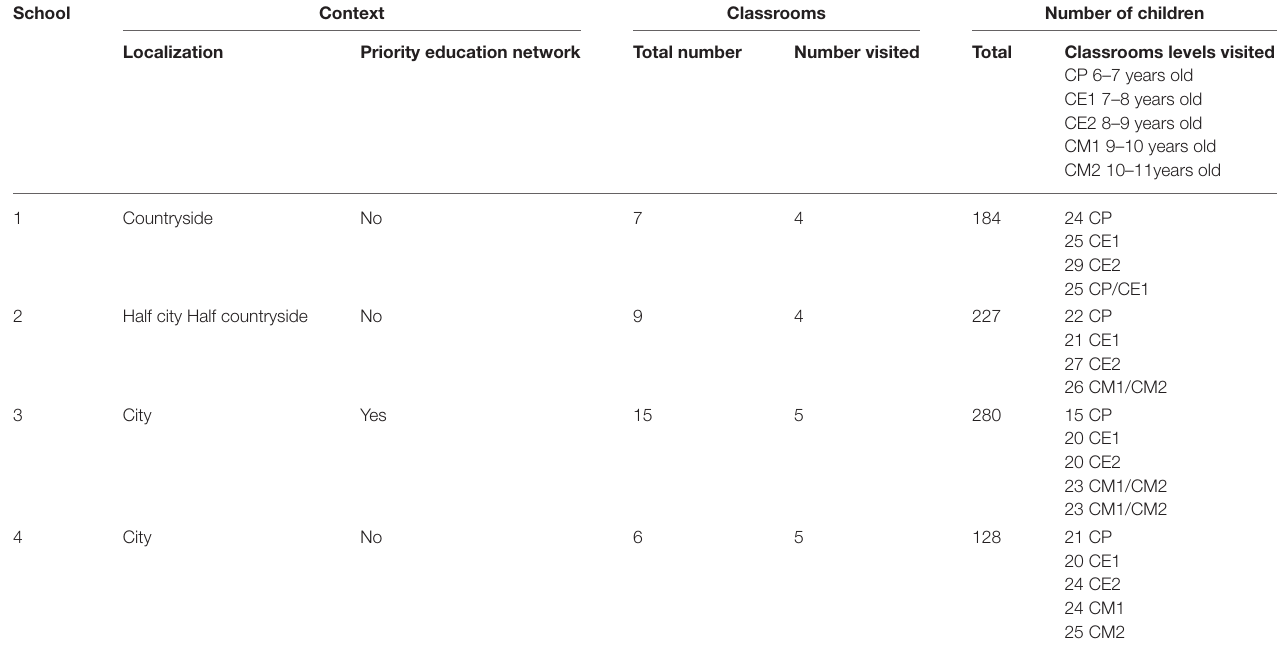
TABLE 1 | Sociodemographic